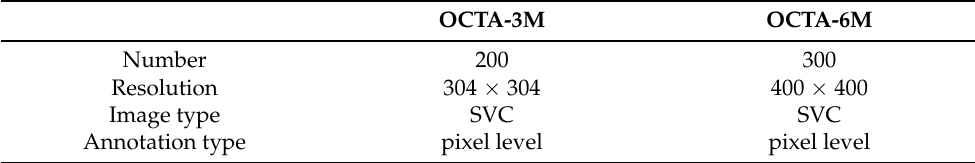
Table 2. Details of the OCTA-500 * dataset.